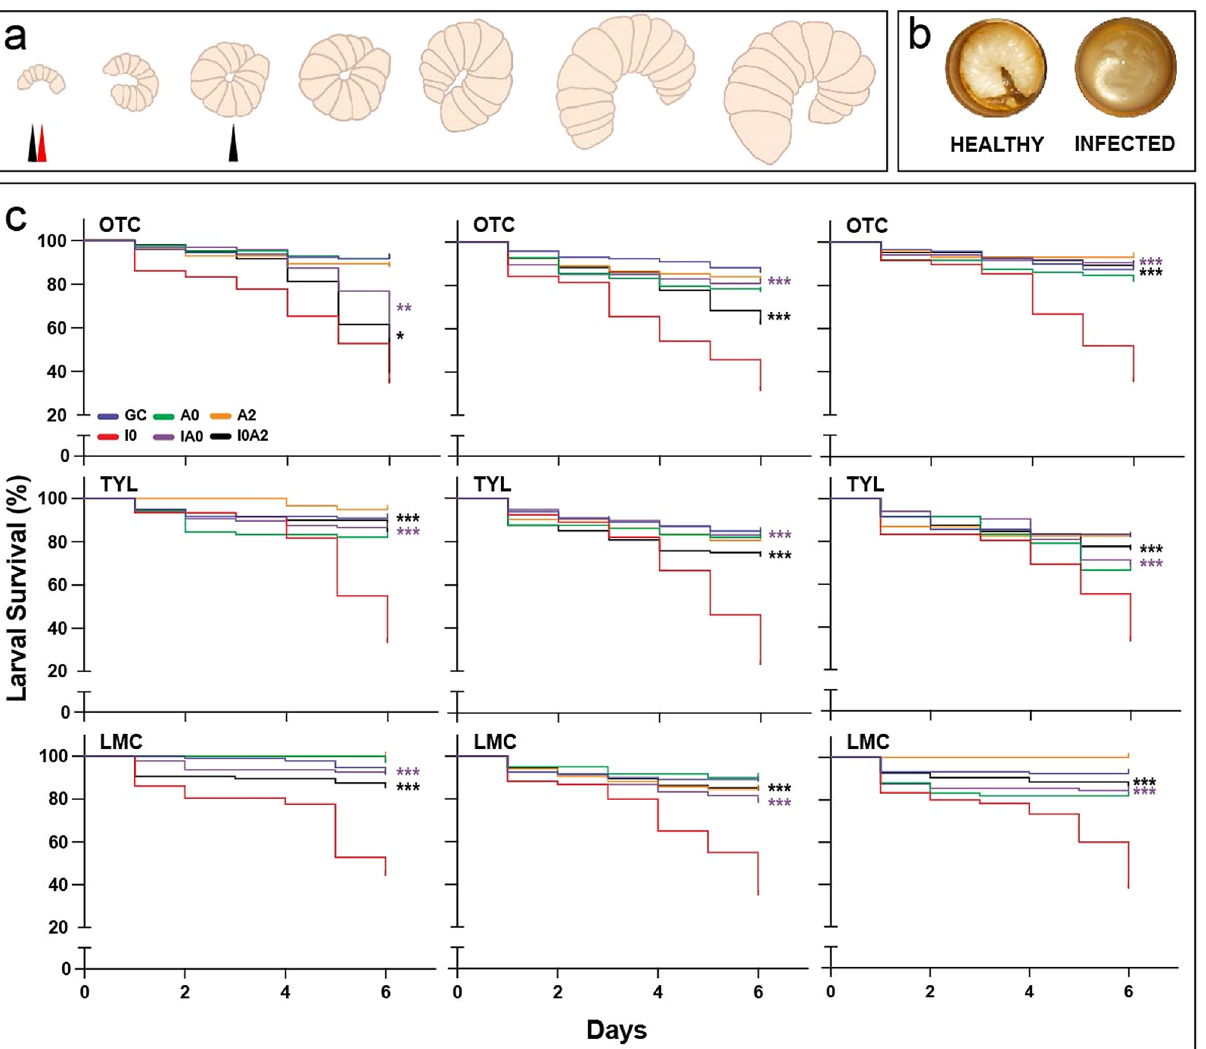
Figure 1. Results of in vitro larval rearing experiments upon exposure to M. plutonius with and without antibiotics. ( a ) Cartoon representation of typical growth of healthy larvae during a week-long in vitro rearing experiment. The red arrow indicates the day at which larval infection with 50 CFU of M. plutonius 2019BC1 occurred (d0), while the black arrows indicate the days on which an antibiotic was first administered (d0 or d2). ( b ) Representative phenotypes of healthy and infected larvae. Healthy d6 larvae are white and plump, while infected d6 larvae are typically smaller in size and typically darker in colour. ( c ) Survival of in vitro reared honey bee larvae based on Table 2, excluding 1000 μg/mL OTC. The top three panels, from left to right, display survival in experiments conducted with 1, 10, and 100 μg/mL OTC. The middle and bottom panels display survival in experiments with 33, 330, and 3300 μg/mL of TYL and LMC, respectively. Statistical analysis of the survival was performed using a chi-square two-way association test comparing either IA0 or I0A2 with the I0 and significant differences are denoted by asterisks (* p < 0.1, ** p < 0.001, *** p <